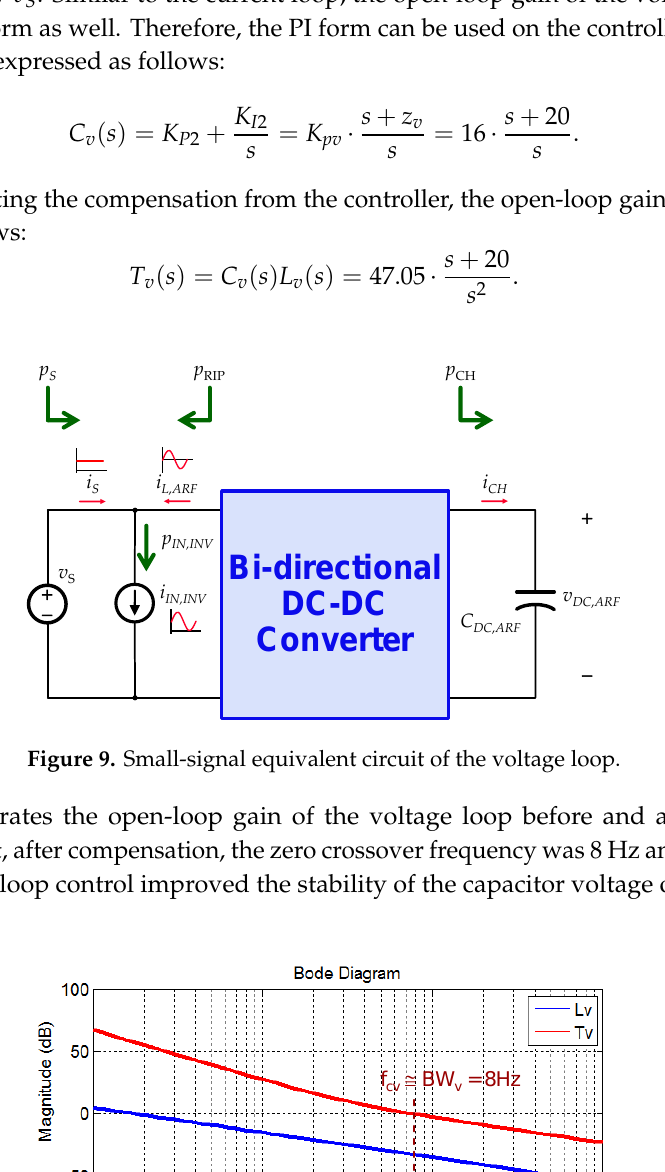
Figure 11. Experimental platform of a 500 W single-phase DC/AC conversion integrated with ARF. Table 1. Component parameters of the ARF circuit. Component